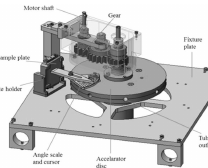
Figure 1. Centrifugal accelerator erosion tester model comprising of eight internal tubes